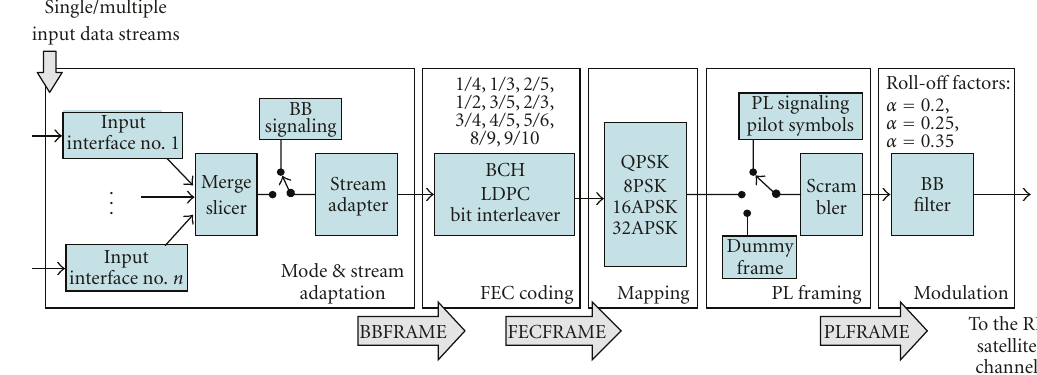
Figure 8: DVB-S2 physical layer transmitter block diagram (taken from